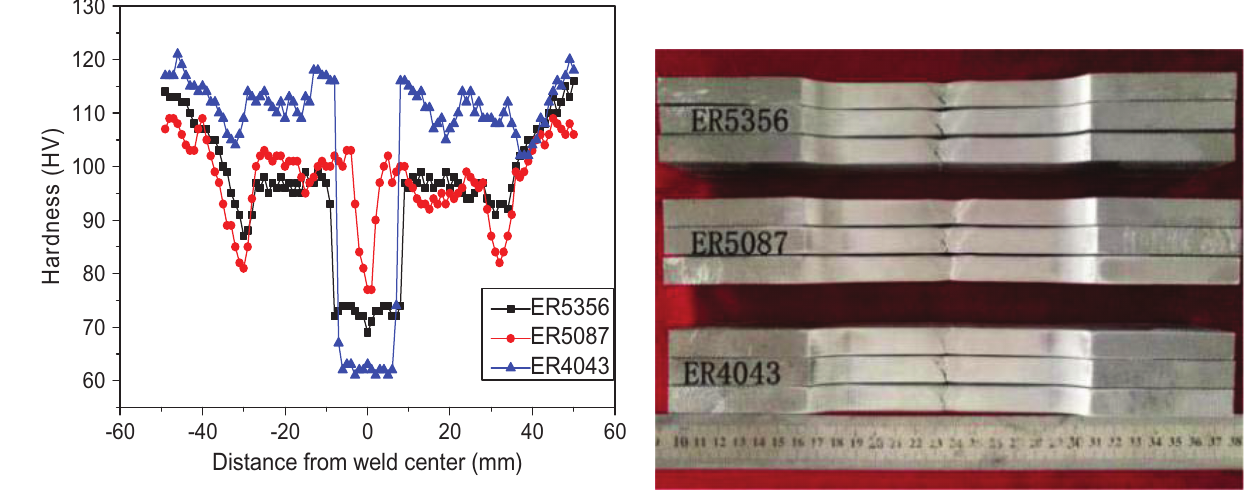
Figure 7: Microhardness distribution.